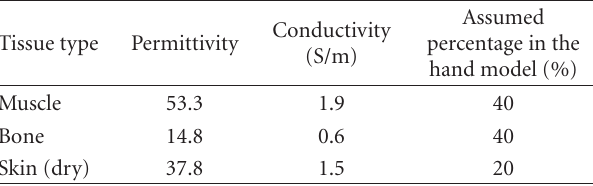
Table 1: Tissue properties and their assumed percentage in the hand